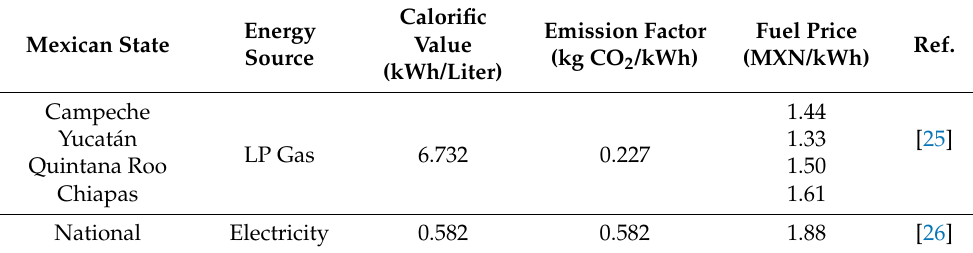
Table 4. Costs, and energy and environmental properties of energy sources used in